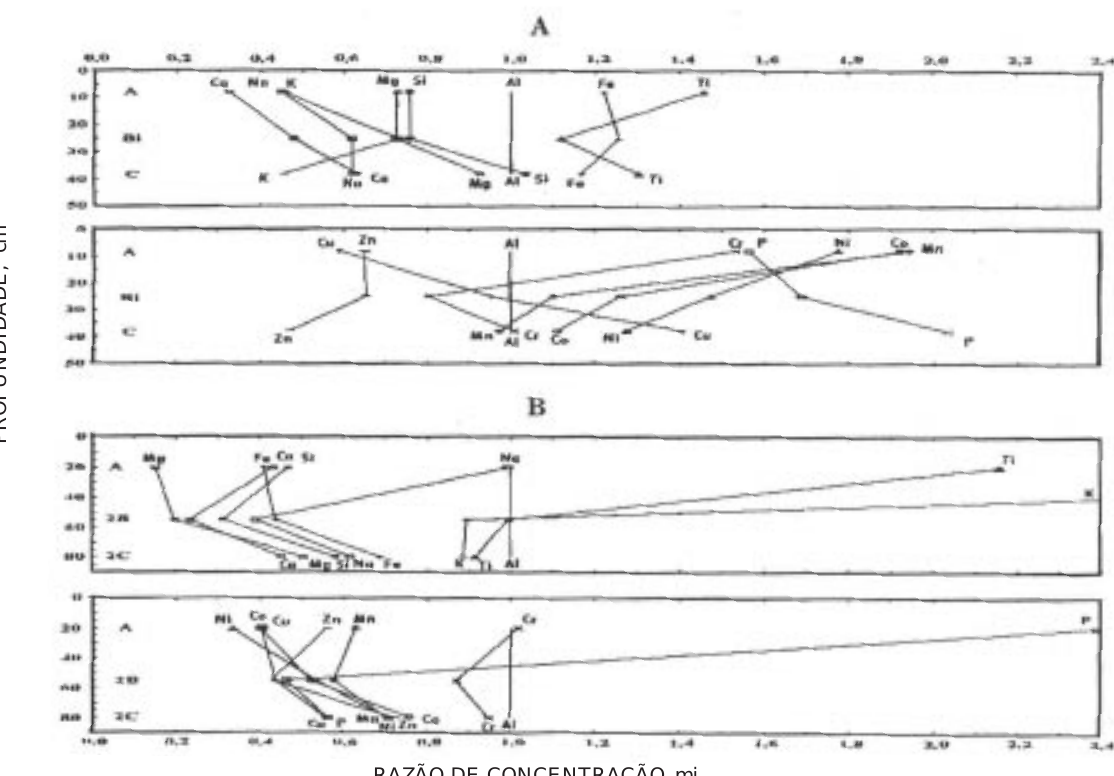
RAZÃO DE CONCENTRAÇÃO, mi Figura 3. Relação entre a razão de concentração dos elementos (mi) e a profundidade no perfil 2 (A) e perfil 3 (B).